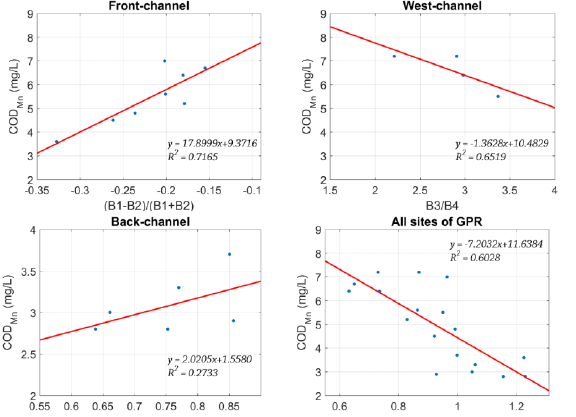
Figure 7. The COD Mn regression models based on GF-1 PMS band setting